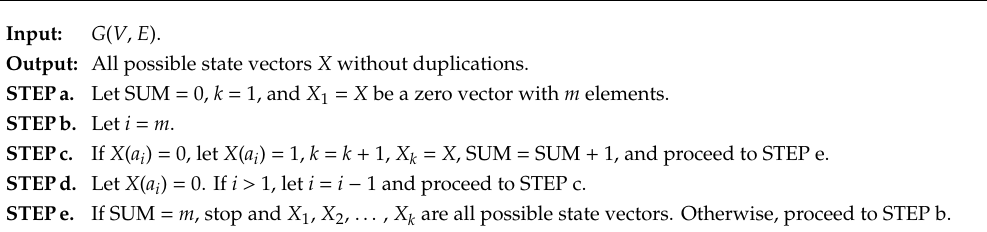
Algorithm 1. Pseudocode for binary-addition tree [18]